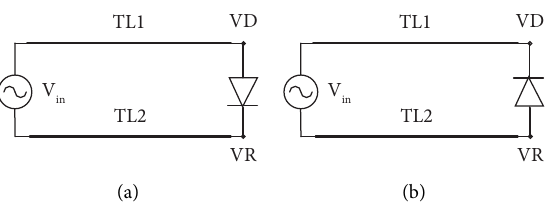
Figure 6: Circuit combining transmission line and